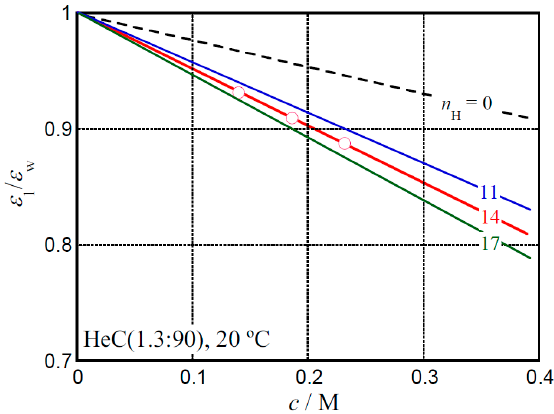
Figure 5. Relationship between the values of ε 1 / ε w and concentration, c , for aqueous solution of HeC(1.3:90) at T = 20 °C.